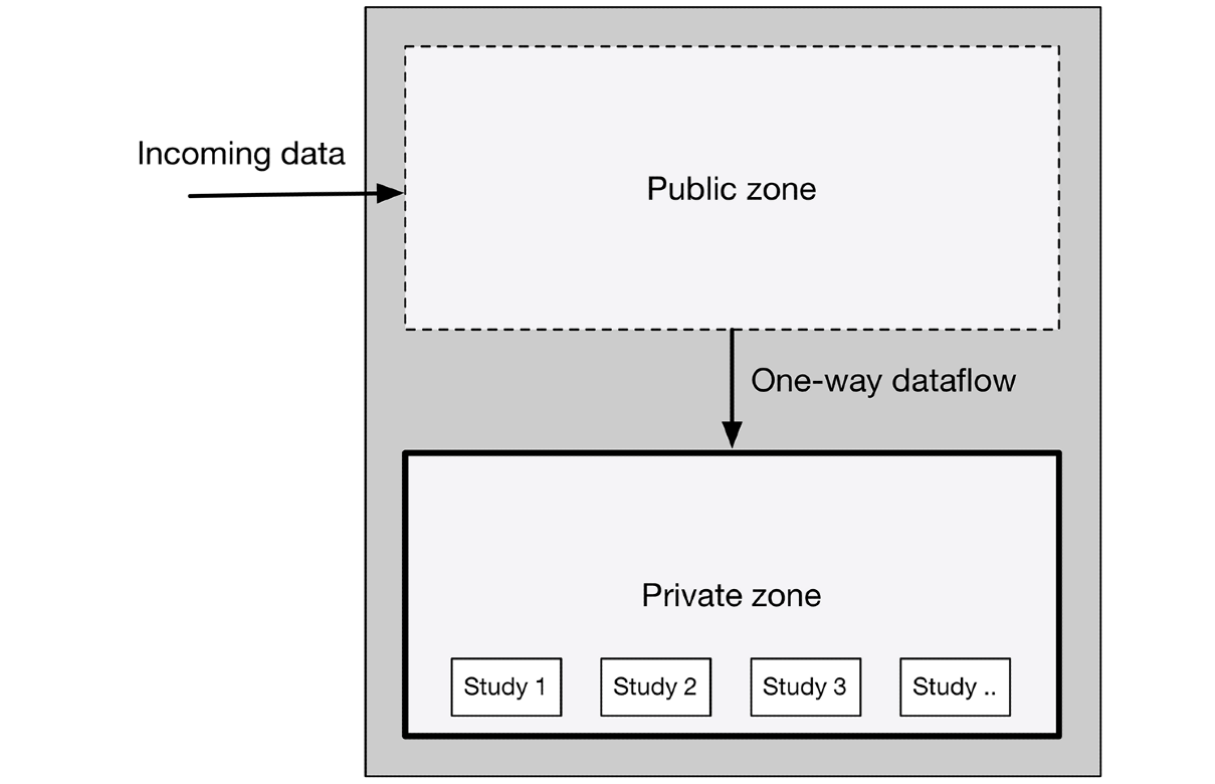
Figure 3. Public and private zone isolation overview featuring separated data